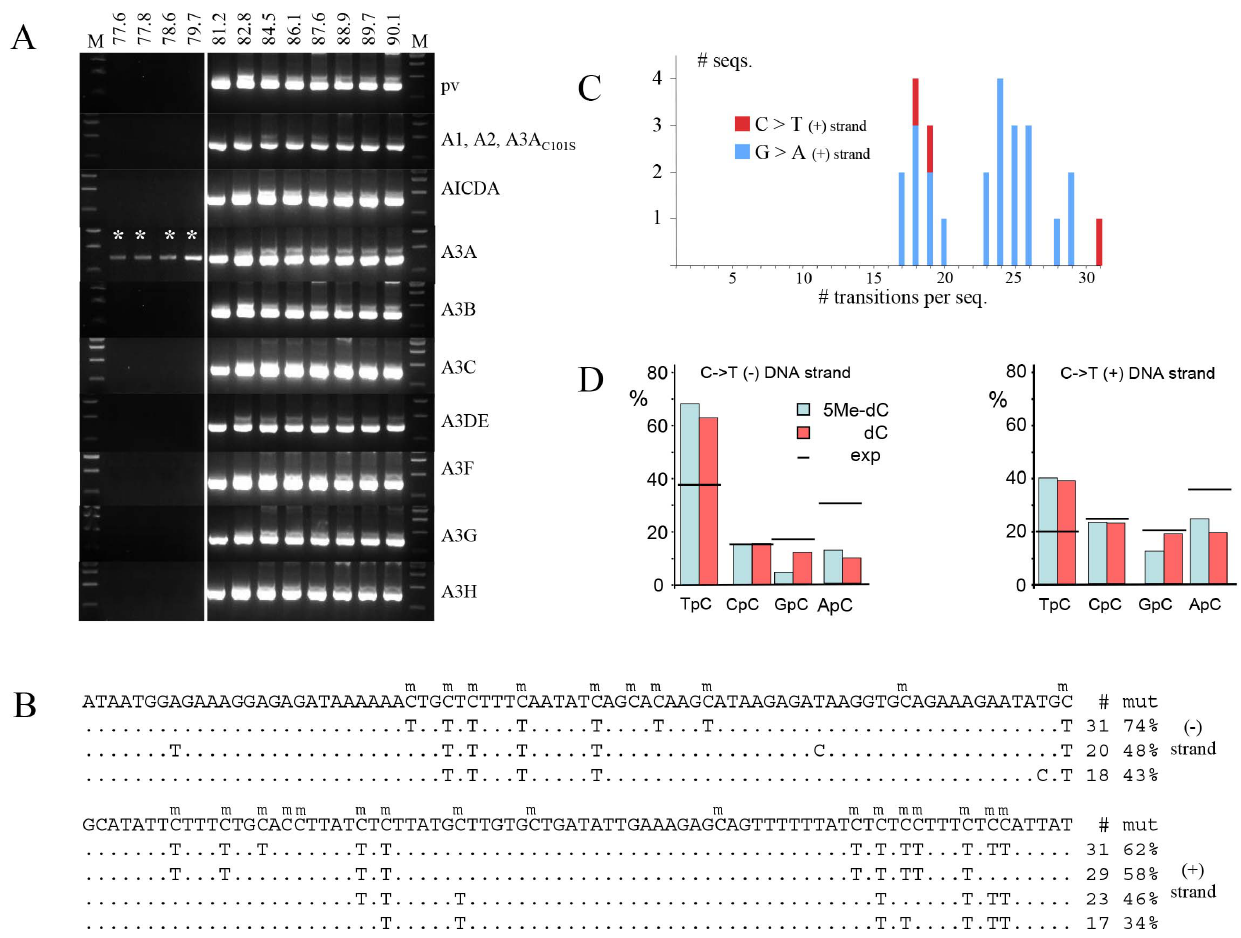
Figure 1. A3A deamination of 5-methylcytidine in ssDNA. A) Agarose gels of 3DPCR products derived from PCD transfected QT6 cells by denatured totally 5MeC substituted HIV env DNA. The temperatures refer to the differing PCR Tds used. The minimal Td for unedited DNA is 81.2 u C. pv=plasmid expression vector. DNA (310 bp) recovered at Td , 81.2 u C, with an astericks, were cloned and sequenced. This experiment was performed in triplicate. B) A selection of A3A deaminated 5MeC substituted HIV DNA sequences (only 80 bp of 310 bp were presented); only differences are shown. To the left are the number and % of 5MeC bases deaminated per sequence. C) Distribution of edited sequences recovered from the 79.7 u C reaction. D) Dinucleotide preference for A3A deamination of 5MeC (blue) and C (red). There was no 3 9 effect. The expected (exp) values based on the dinucleotide composition of the plus and minus strands are given by horizontal lines.